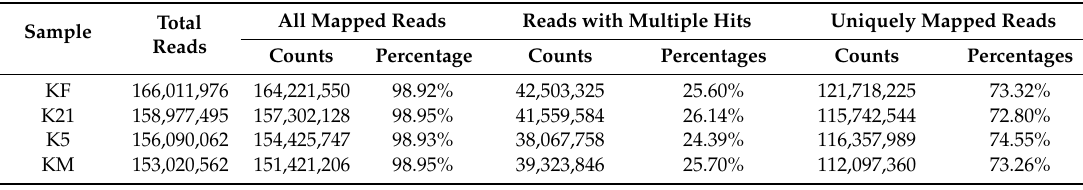
Figure 1. Phenotype of traits associated with the dehulling: ( A ) seed loading branch of Tartary buckwheat as male parent; ( B ) seed loading branch of rice-Tartary as female parent; ( C ) seeds of Tartary buckwheat as male parent; ( D ) seeds of rice-Tartary as female parent; ( E ) “Tartary-buckwheat-like” seeds in the F2 population; ( F ) “Tartary-buckwheat-like” seeds in the F2 population; ( G ) “rice-Tartary- like” seeds in the F2 population; and ( H ) “rice-Tartary-like” seeds in the F2 population.